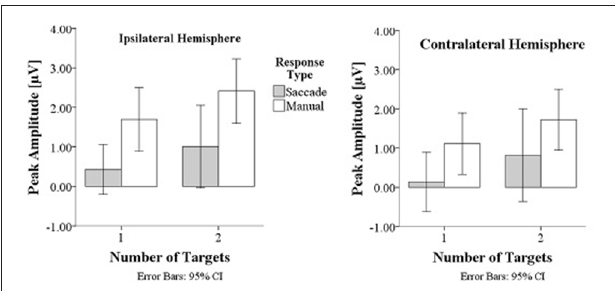
FIGURE 9 | Peak amplitudes are greater in manual response conditions than in saccade conditions and greater for double than for single